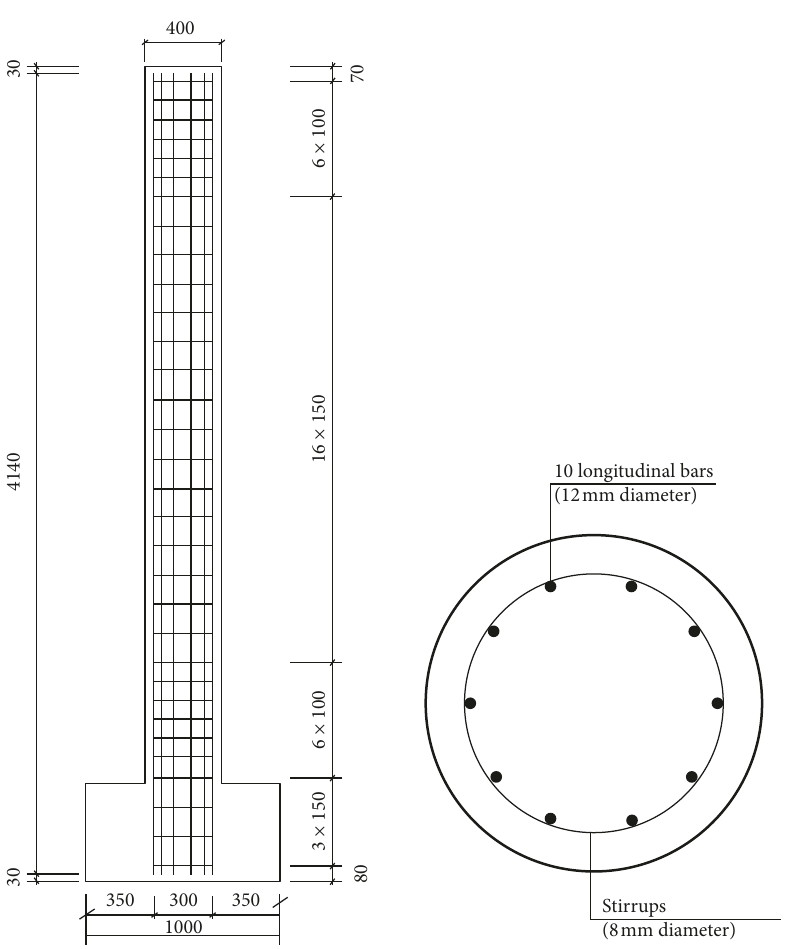
Figure 8: Geometry and reinforcement details of specimen JS5.